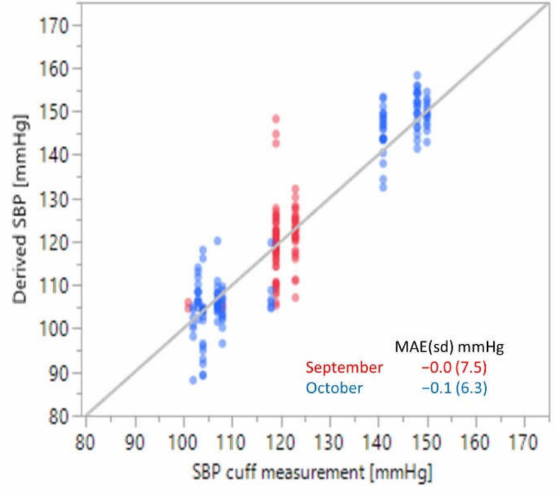
Figure 4. Proof-of-concept results for a single person convolutional neural network algorithm trained on cuff data collected from March through May and then tested in September and